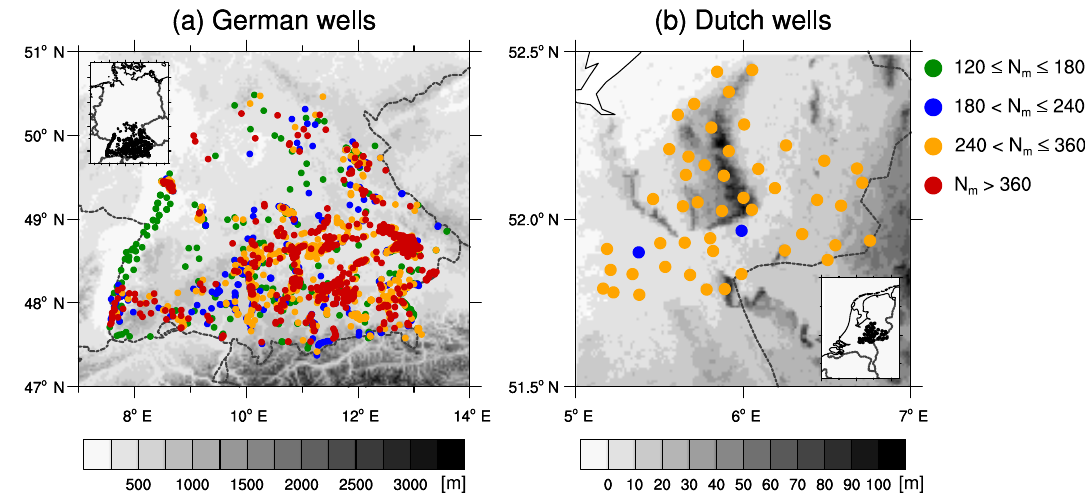
Figure 1. The locations of (a) German and (b) Dutch wells overlaid on the respective terrains. The marker colors show the number of months N m with available records during the periods 1950–2013 and 1988–2013 for German and Dutch wells, respectively.